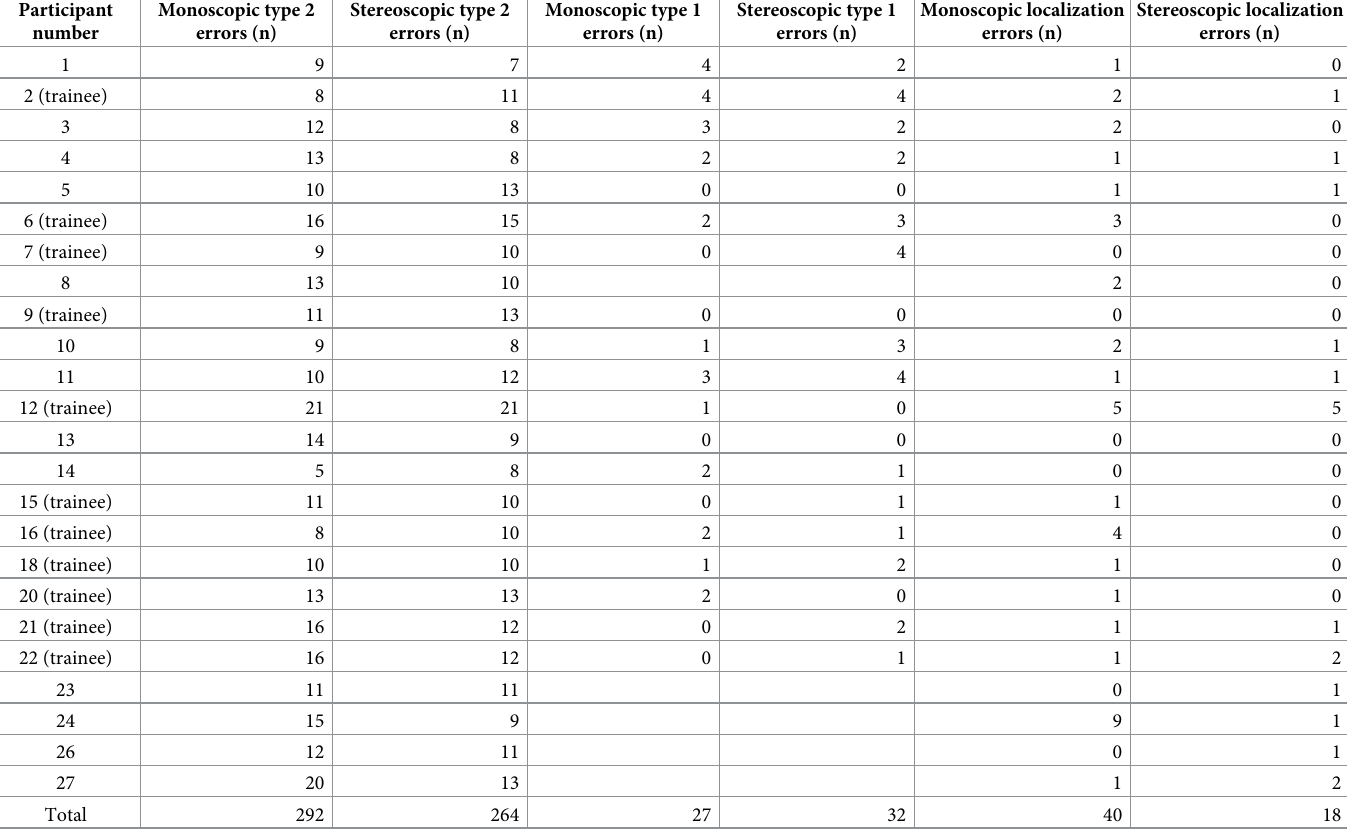
Table 1. Errors in identifying PVS and localization of veins for monoscopic and stereoscopic